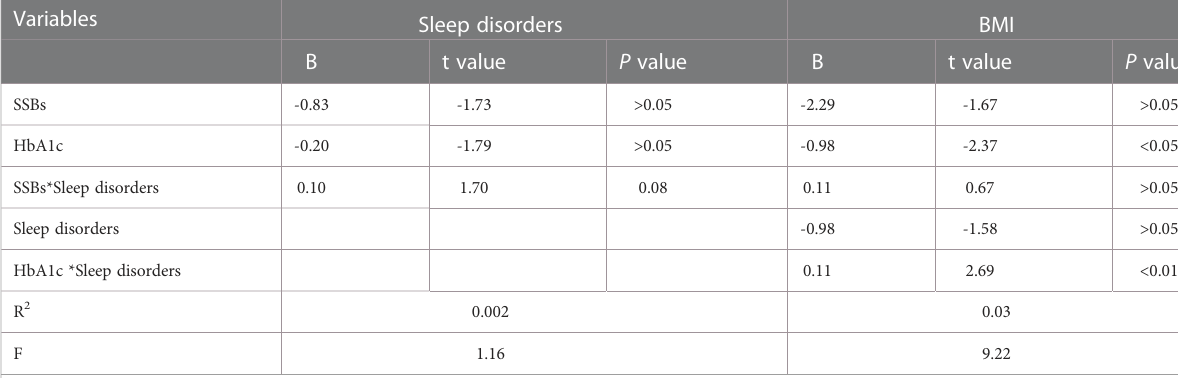
TABLE 11 Model characteristics for the conditional process